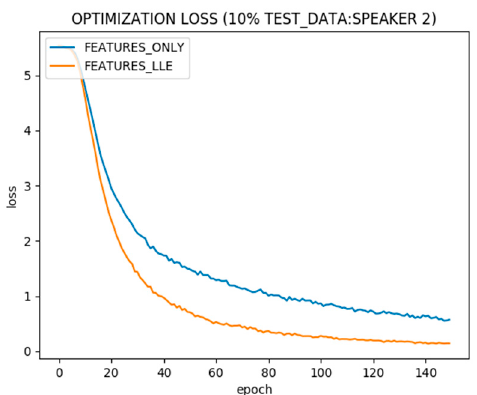
Figure 7. Training error vs. iterations with and without Locally Linear Embedding (LLE) (10% test and 90% training data).